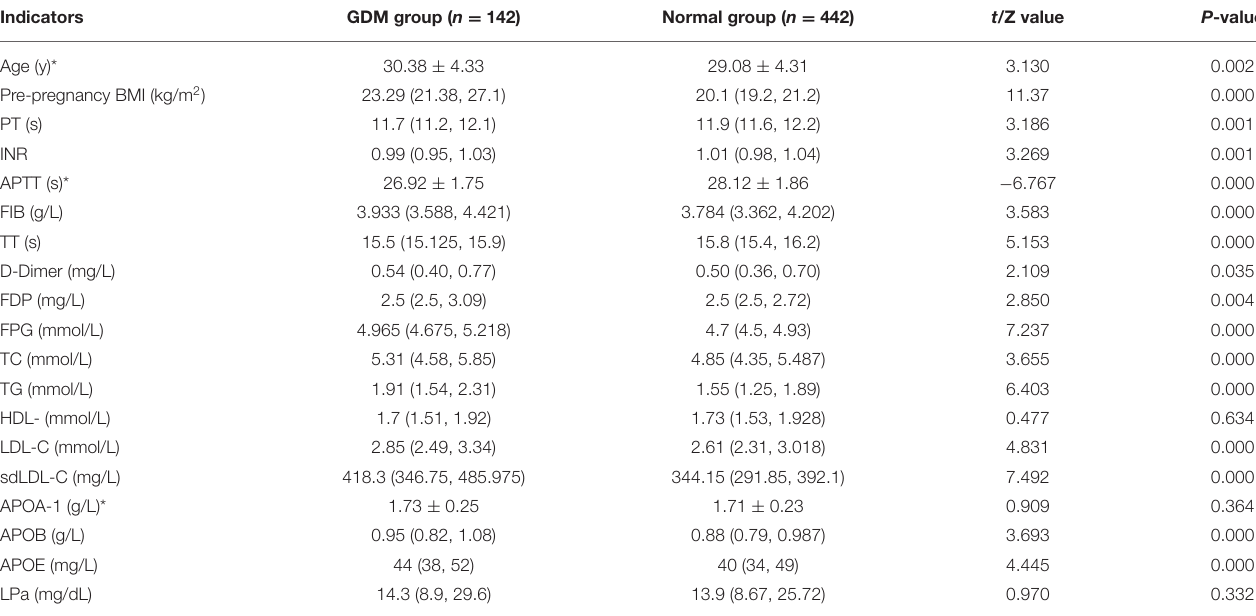
TABLE 2 | Comparison of basic clinical data of the two groups in pregnant women.